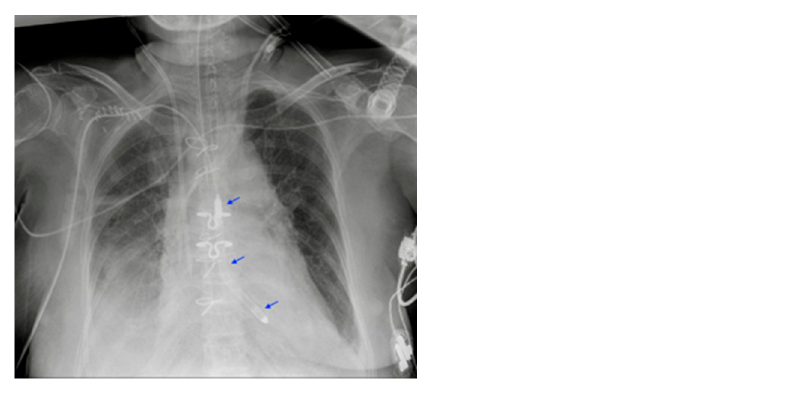
Figure 16. Impella in the correct position. Device is placed into the left ventricle and in the ascending aorta through the aortic valve (blue arrows).